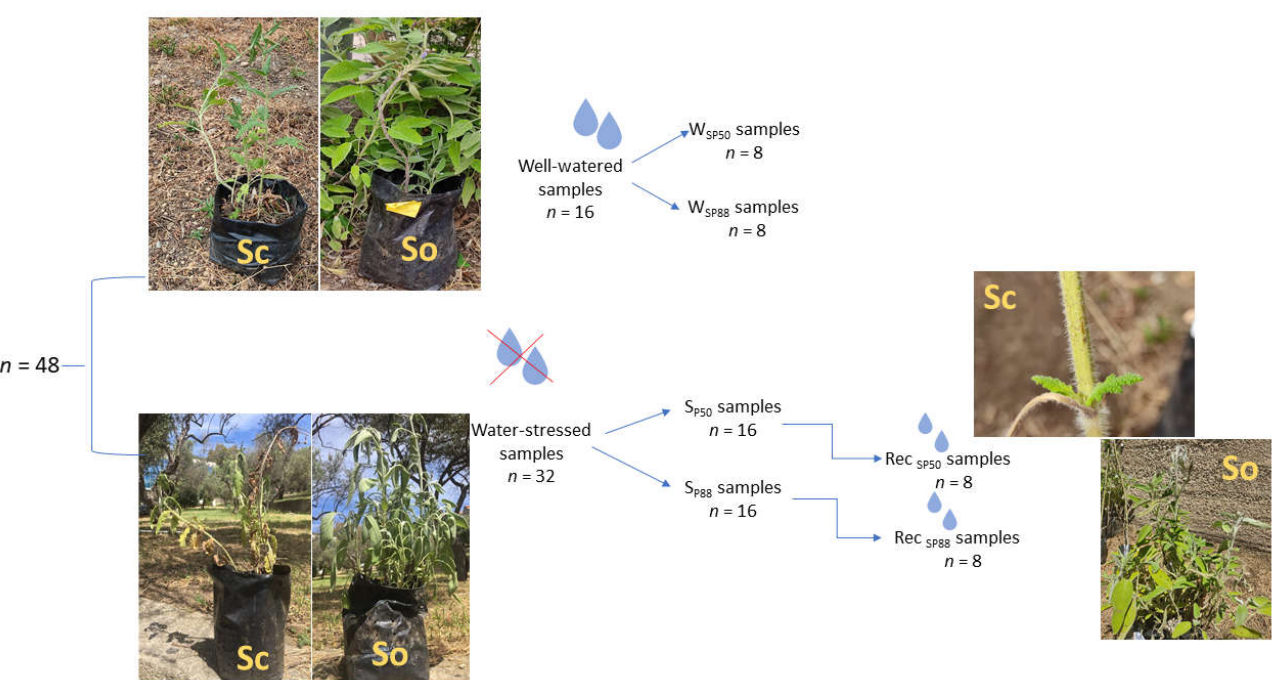
Figure 6. Experimental design: 48 potted samples of S. ceratophylloides ( Sc ) and S. officinalis ( So ) were divided into two groups: watered samples ( n = 16) and water–stressed samples ( n = 32). Watered samples (W) were regularly irrigated at field capacity during the experimental period and measured, as control samples, at the same time as water–stressed samples (i.e., 8 samples for each drought treatment). Water–stressed samples were further divided into two groups subjected to a mild (i.e., S P50 samples, n = 16) and a severe (S P88 , n = 16) water-stress treatment, respectively. A subset of these samples ( n = 8) was measured when the imposed water stress level was reached, while the other subset of drought-treated samples ( n = 8) was re-irrigated at field capacity (i.e., Rec SP50 and Rec SP88 samples) and then measured.